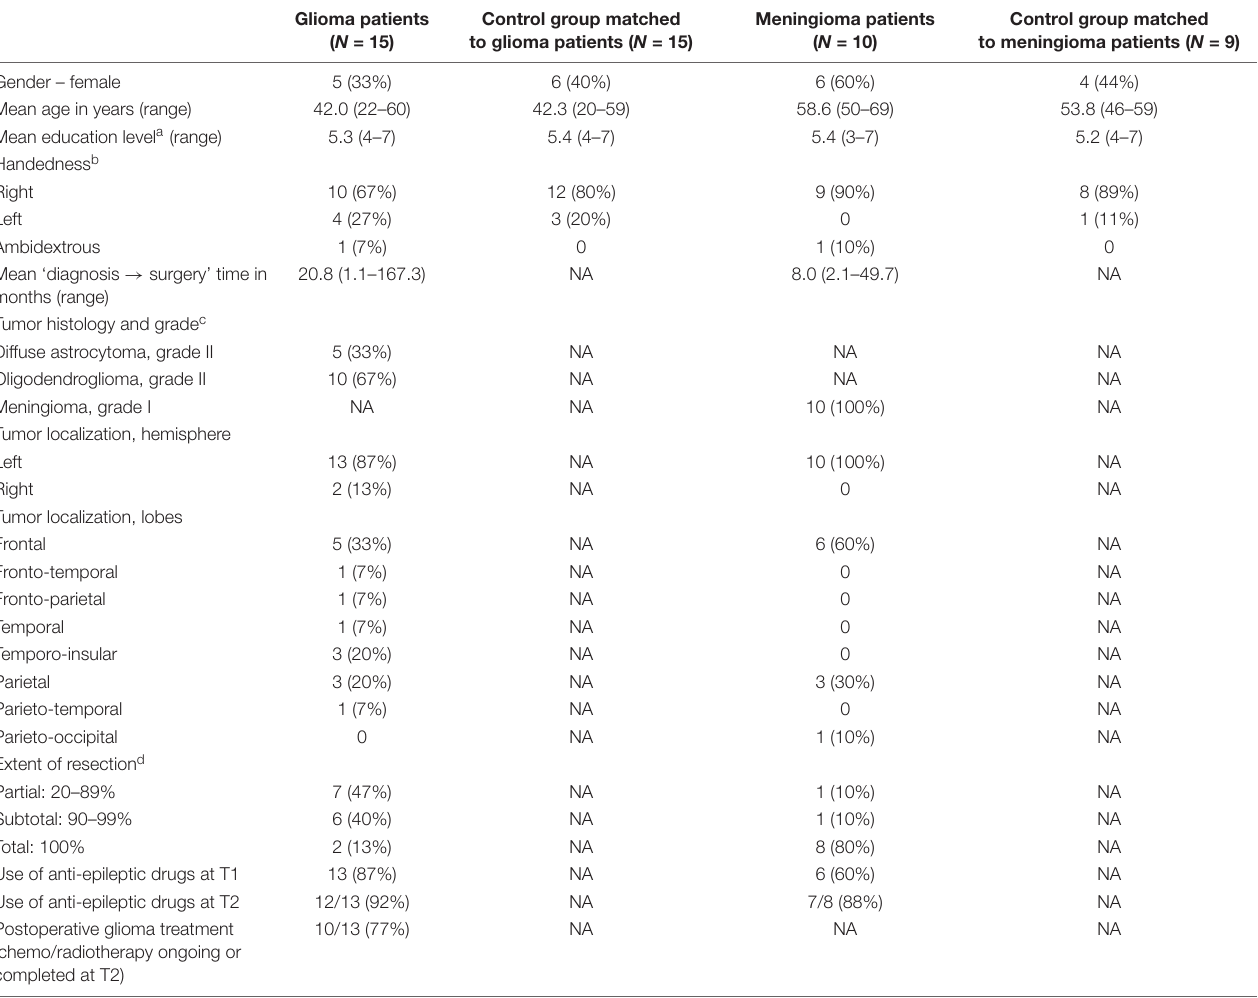
TABLE 3 | Demographic and clinical characteristics of the participants: number of participants (and percentage) or mean (and range).